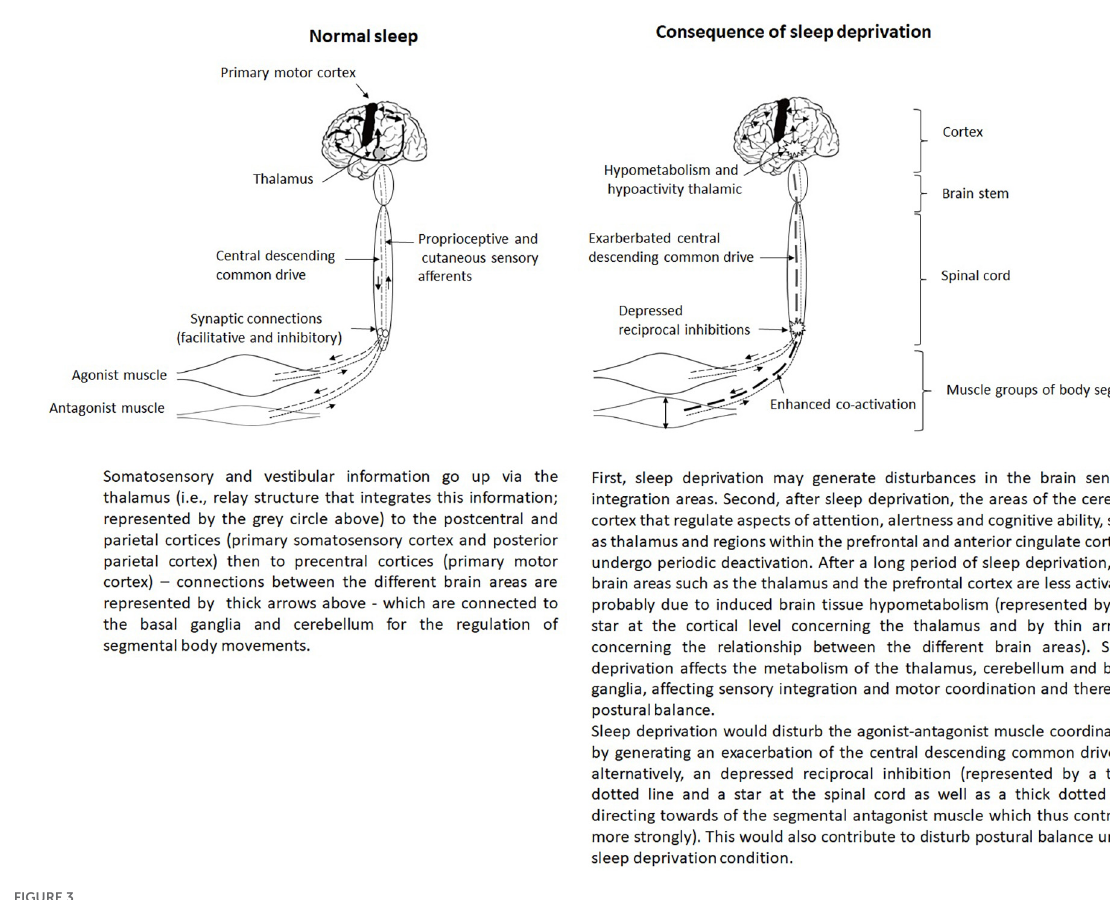
FIGURE3 Representation of the regulation of postural balance tasks involving the central integration of sensory inputs and motor responses.